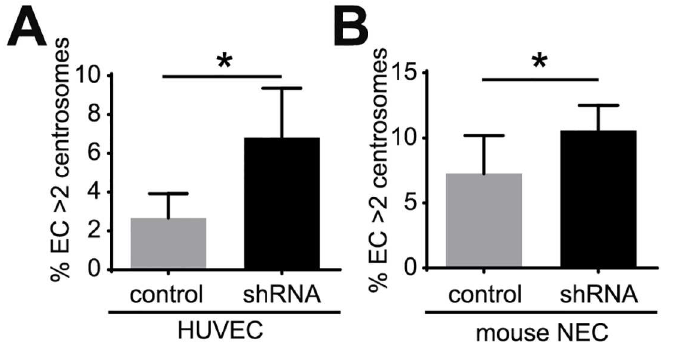
Fig 5. Down-regulation of p53 induces excesscentrosomes in EC. (A) Frequency of excess centrosomes in HUVEC infected with humanp53 shRNA. (B) Frequencyof excess centrosomesin normal mouse endothelial cells (NEC) infected with mouse p53 shRNA. Error bars, standard deviationfrom mean. Statistics: two-tailed unpairedStudent’s t-test. * , p (cid:20)